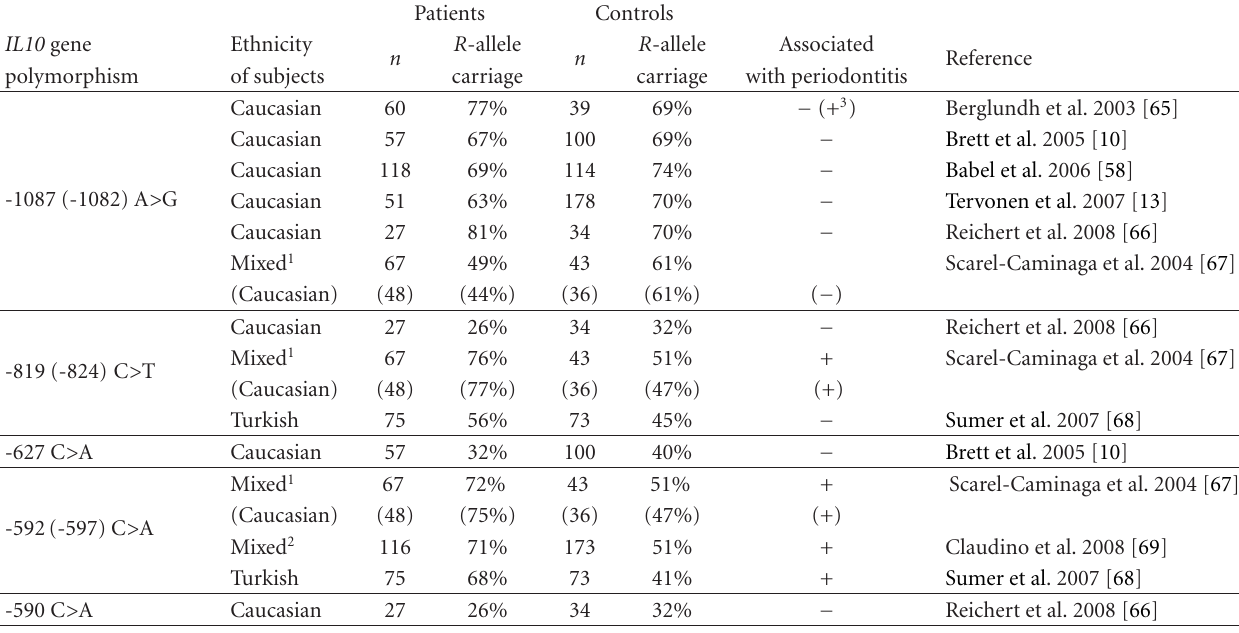
Table 8: IL10 gene polymorphisms and carriage rate of the Rare ( R )-allele in case-control studies and association with susceptibility to chronic